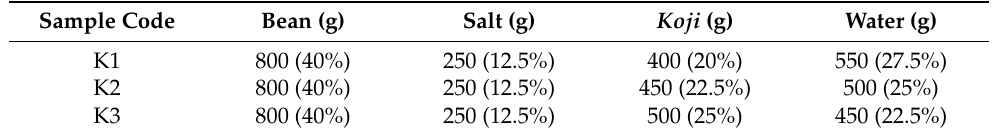
Table 1. Doenjang with different amount of koji samples included in this